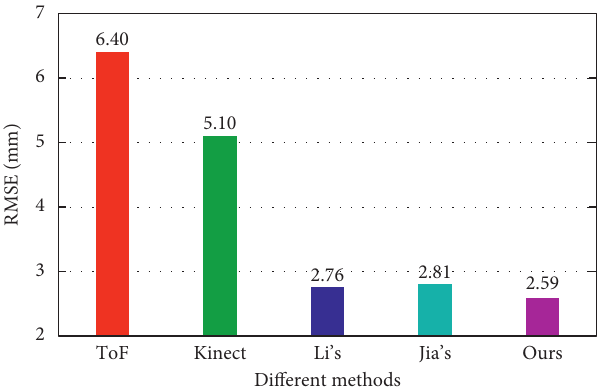
Figure 12: RMSE of ToF, Kinect, Li’s method [18], Jia’s method [15], and the proposed